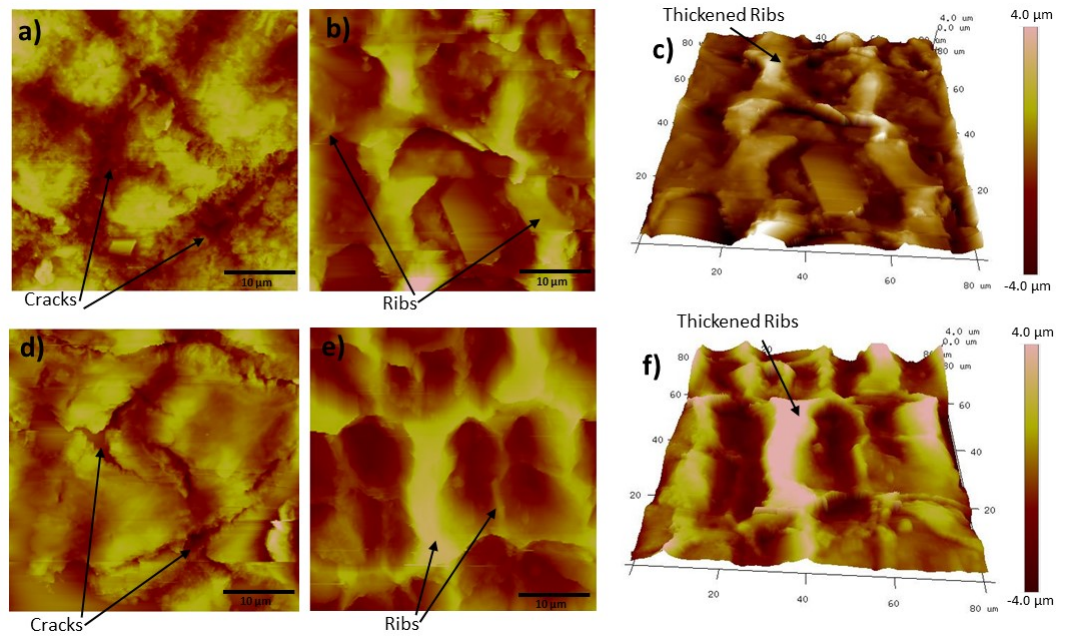
Figure 4. Topographic images obtained by AFM. Figures ( a – c ) were obtained from “golden” apple: ( a ) 2D image of the outer face and ( b , c ) 2D and 3D images, respectively, from the inner face; Figures ( d – f ) were obtained from “red” apple: ( d ) 2D image of the outer face and ( e , f ) 2D and 3D images, respectively, of the inner face.